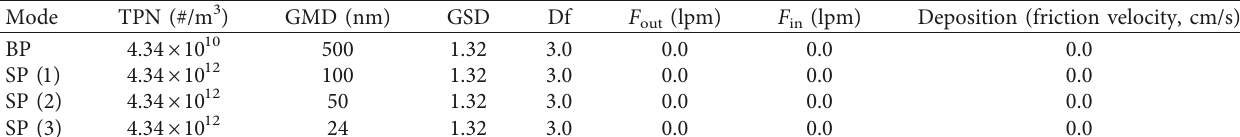
Table 1: Characteristics of both BP and SP modes.